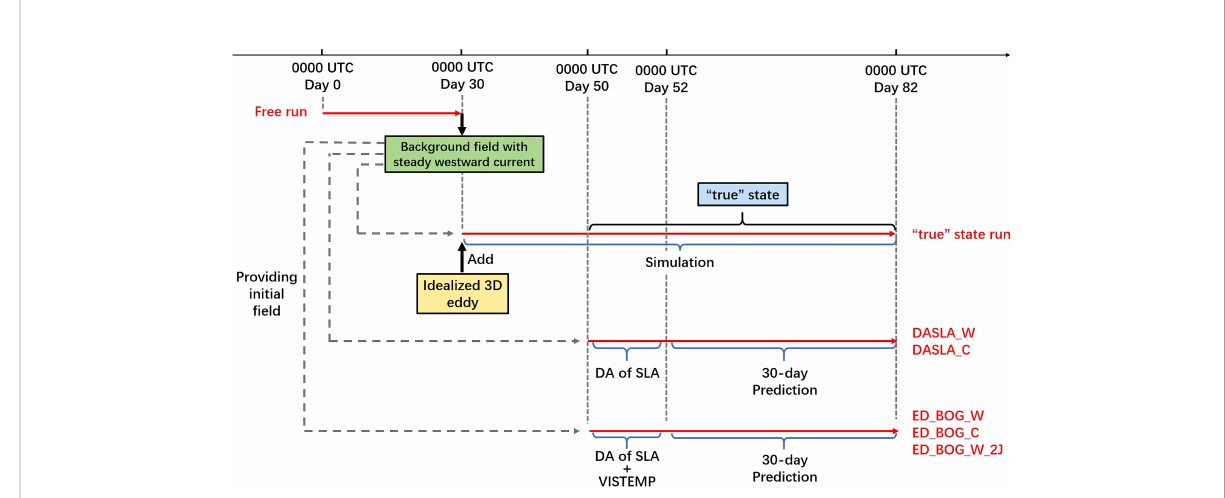
FIGURE 5 The fl owchart of generation of “ true ” state and idealized prediction experiments.